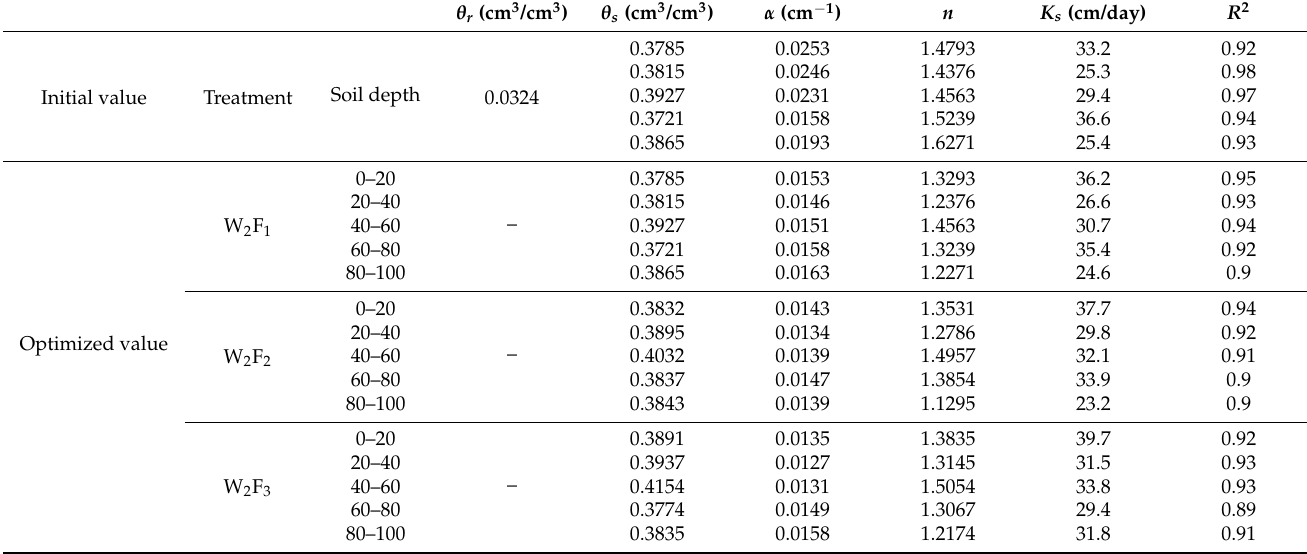
Table 4. Parameters of the V-G model under the fertilizer (NH 4 NO 3 )